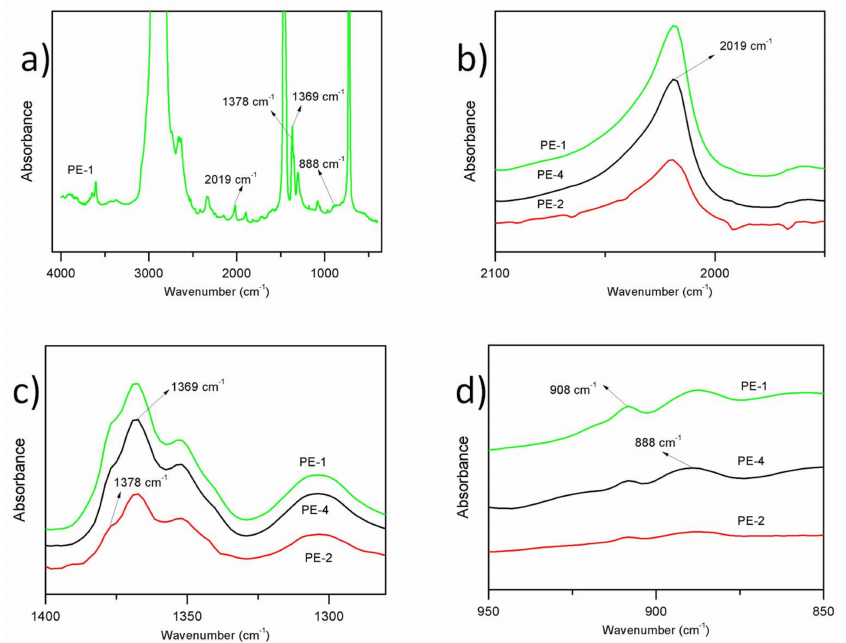
Figure 4. IR analysis results. ( a ) IR spectrum of PE-1; ( b ) IR spectrum at 2019 cm − 1 ; ( c ) IR spectrum of methyl groups at 1378 cm − 1 and methylene groups at 1369 cm − 1 ; ( d ) IR spectrum of RCH=CH 2 groups at 908 cm − 1 and R 1 R 2 C=CH 2 groups at 888 cm − 1